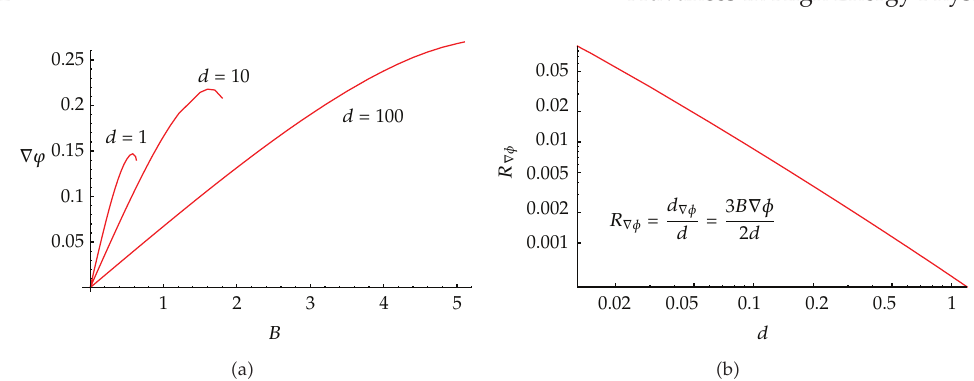
Figure 15: (cid:3) a (cid:4) The pion gradient as a function of B for density d (cid:8) 1 , 10 , 100 at T (cid:8) 0 . 10. (cid:3) b (cid:4) The density ratio of the pion gradient with respect to the total baryon density of the multiquark phase at B (cid:8) 0 . 10 and T (cid:8) 0 . 10 in the double-log